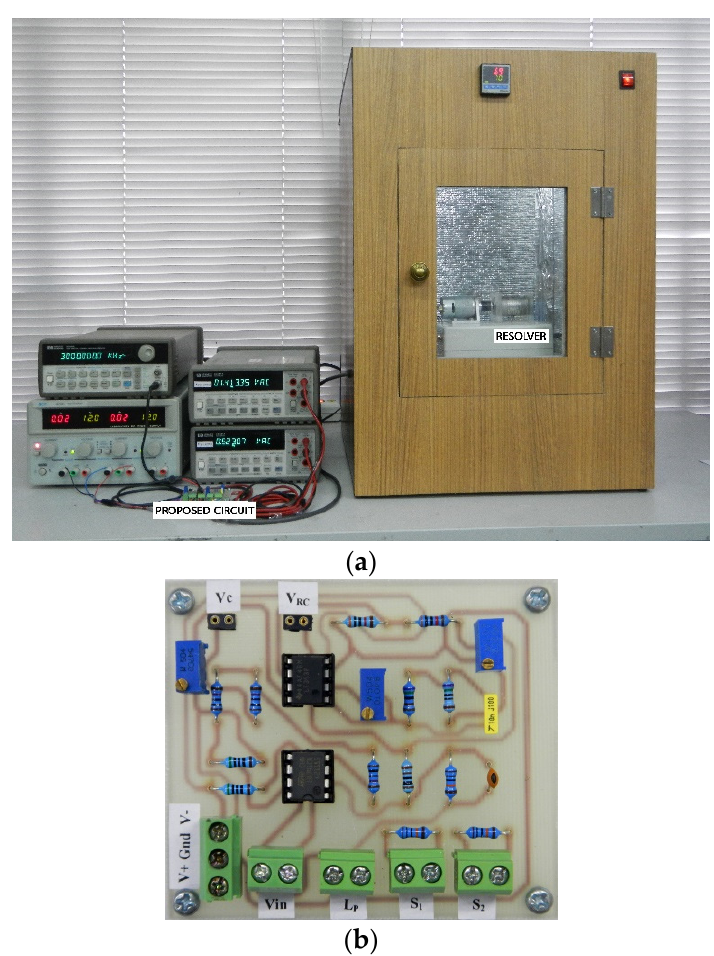
Figure 5. Measured result of signals v RC and v in .